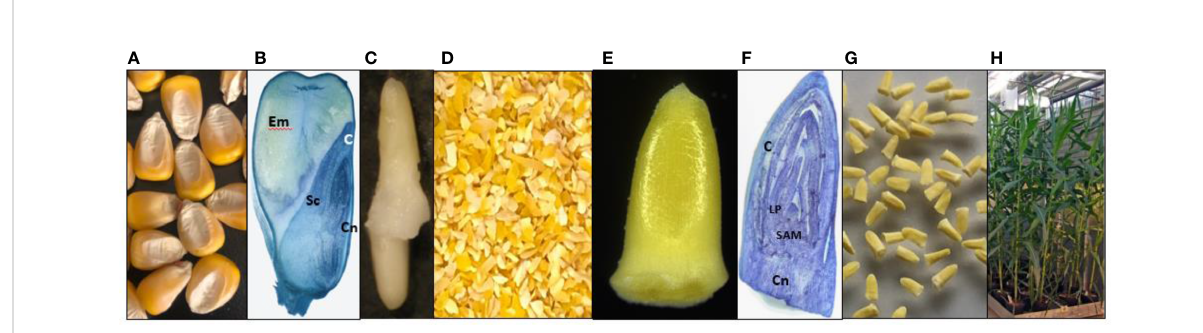
FIGURE 1 Maize seed embryo explants (SEE) for Agrobacterium -mediated direct transformation. (A) Maize dry seeds; (B) Longitudinal section of a maize dry seed cutting through embryo. Endosperm (Em), scutellum (Sc), coleoptile (C) , and coleoptile node (Cn) are indicated; (C) Manually isolated intact embryos with radicle and coleorhiza from an imbibed maize seed; (D) Crushed maize dry seed particles; (E) A magni fi ed maize SEE; (F) Longitudinal section of an imbibed SEE with coleoptile (C) , leaf primordia (LP), shoot apical meristem (SAM) and coleoptile node (Cn); (G) Puri fi ed SEE for transformation; (H) healthy maize plants from SEE grown in green house. (Panels B – F were stained by 0.1% toluidine blue and made available by Mrs. Olivia